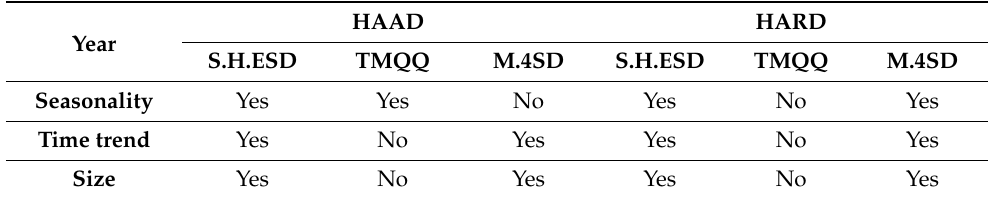
Table 3. Summary of method consistency with seasonality, time trend and size of HAADs and